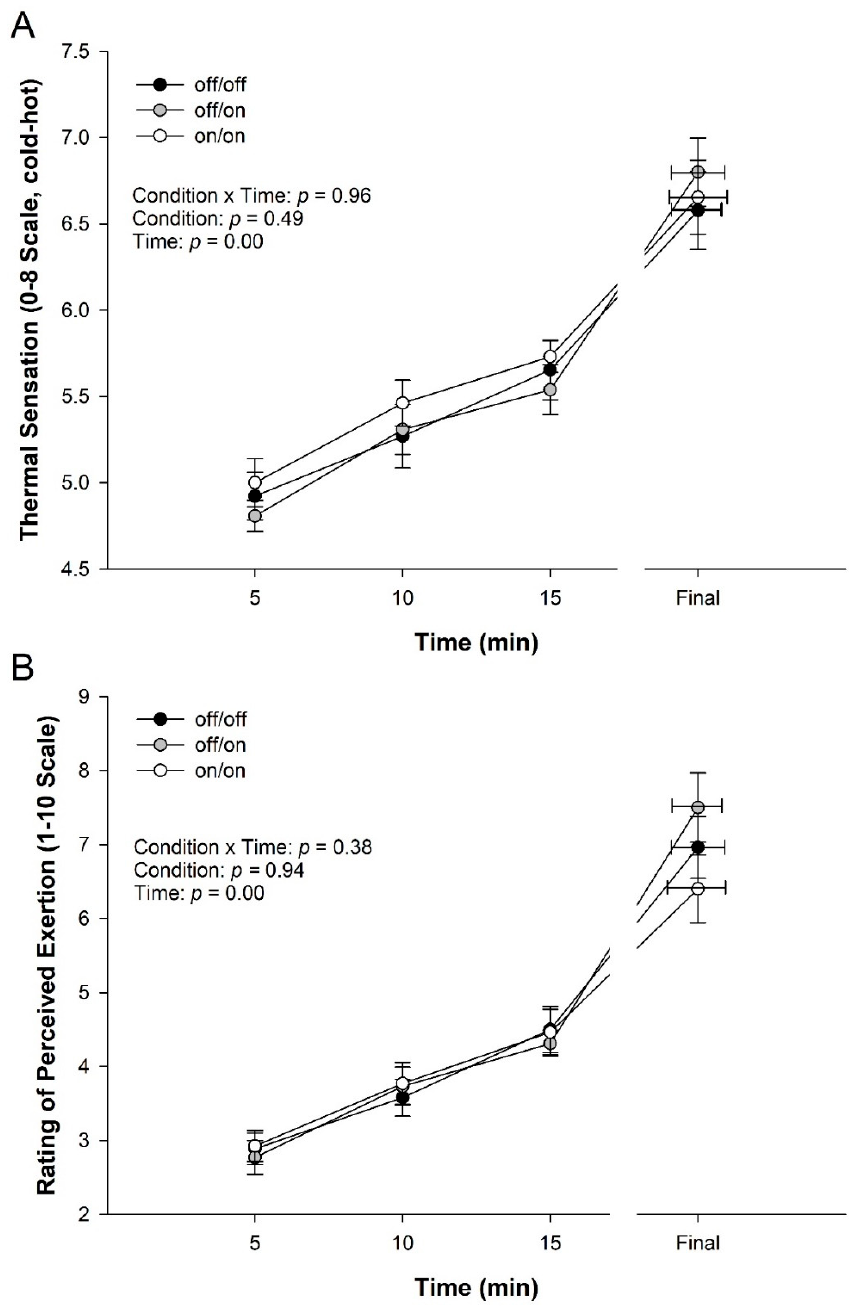
Figure 6. Perceptual measures during 10 km TT. ( A ) Thermal sensation (TS) and ( B ) Rating of perceived exertion. Note: due to safety tolerance in core temperature, trials were ended early and plotted to the shortest time, plus each athlete’s final data point. Data are means ± Standard Error, ( n = 13).